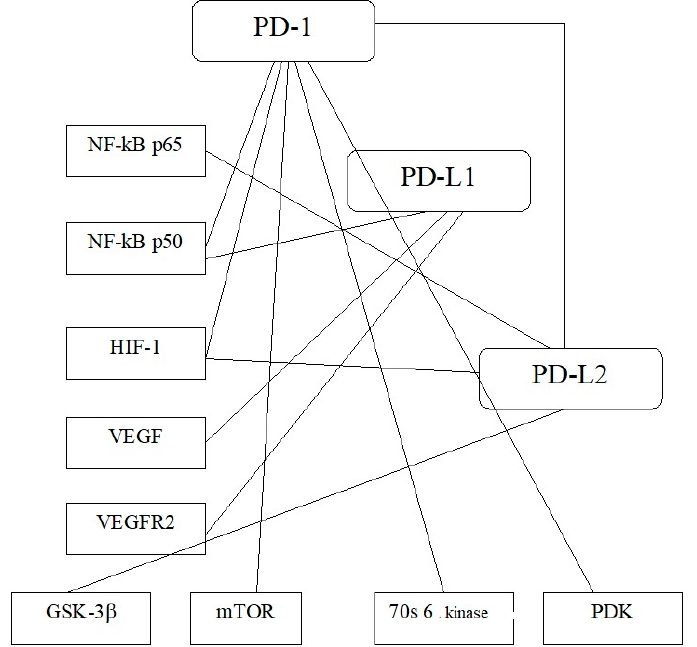
Figure 1. Association between the PD-1, PD-L1, PD-L2 with AKT/mTOR signaling pathway components, transcriptional and growth factors. Note: the correlation analysis revealed the interconnection between the PD receptors and their ligands in ccRCC. The found data indicates the complex associations between the molecular factors that trigger the immunity change.